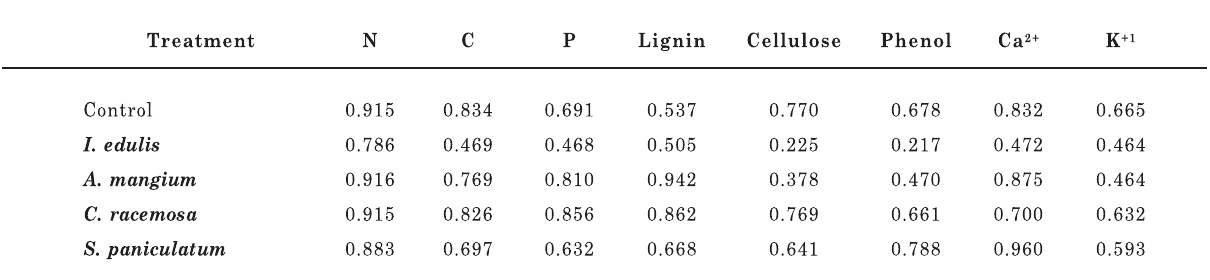
Table 6. Correlation coefficients from regressions of magnesium concentration (g kg -1 ) and some chemical properties (g kg -1 DM) during the incubation period. n =